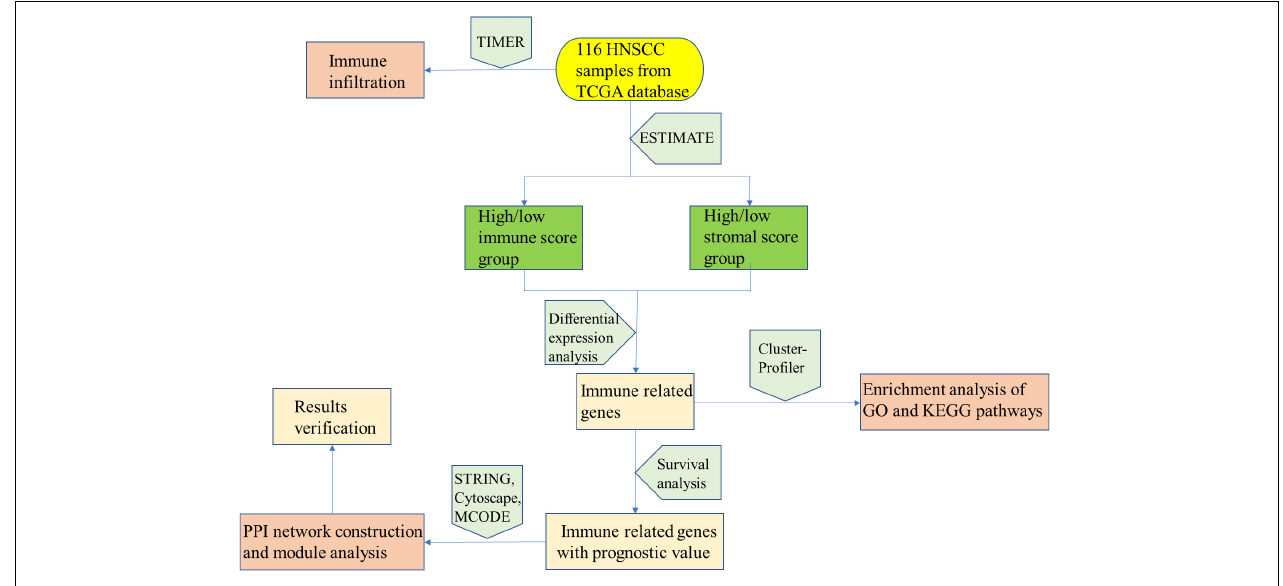
FIGURE 8 | Analysis process structure